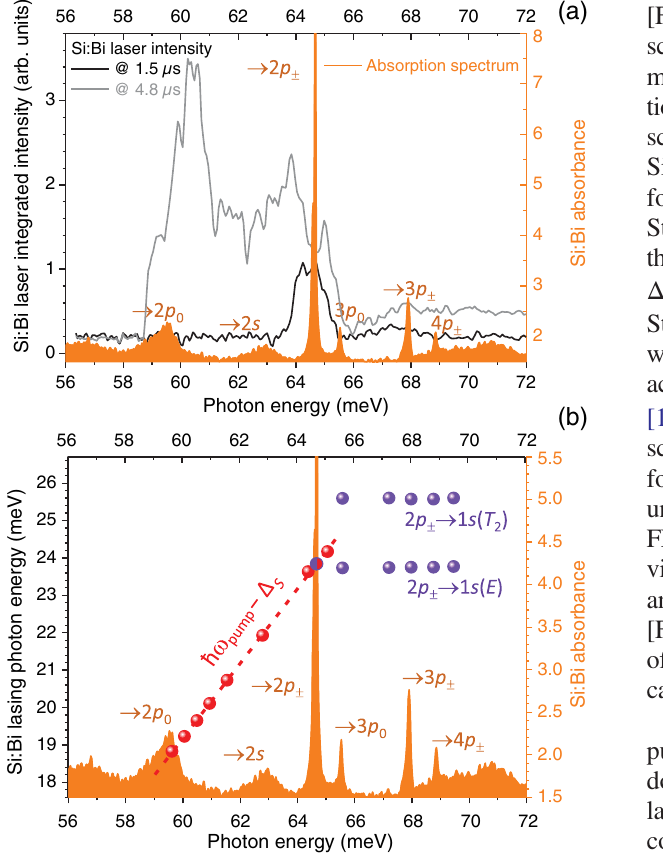
[Figs. 1(b),1(c),1(d), 4(b)]. This is a degenerate four-level